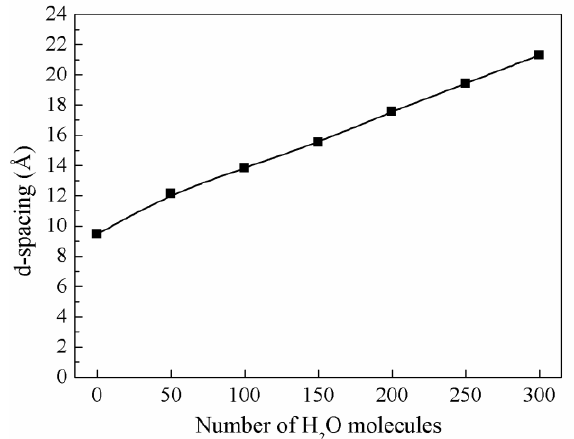
Figure 10. Equilibrium snapshot from an MD simulation of a montmorillonite supercell containing 50 structural water molecules in two neighboring layers at 298 K, 1 bar.